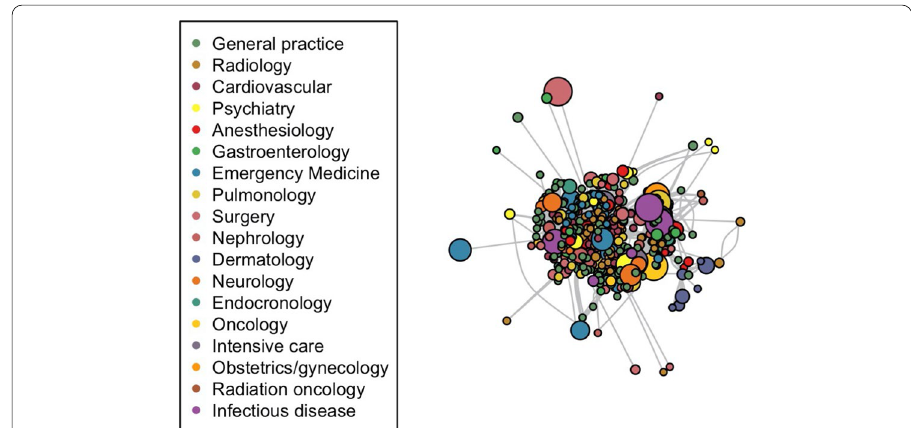
Fig. 2 Illustration of the physician network. The color of nodes corresponds to their specialty and the size of the nodes corresponds to their linchpin